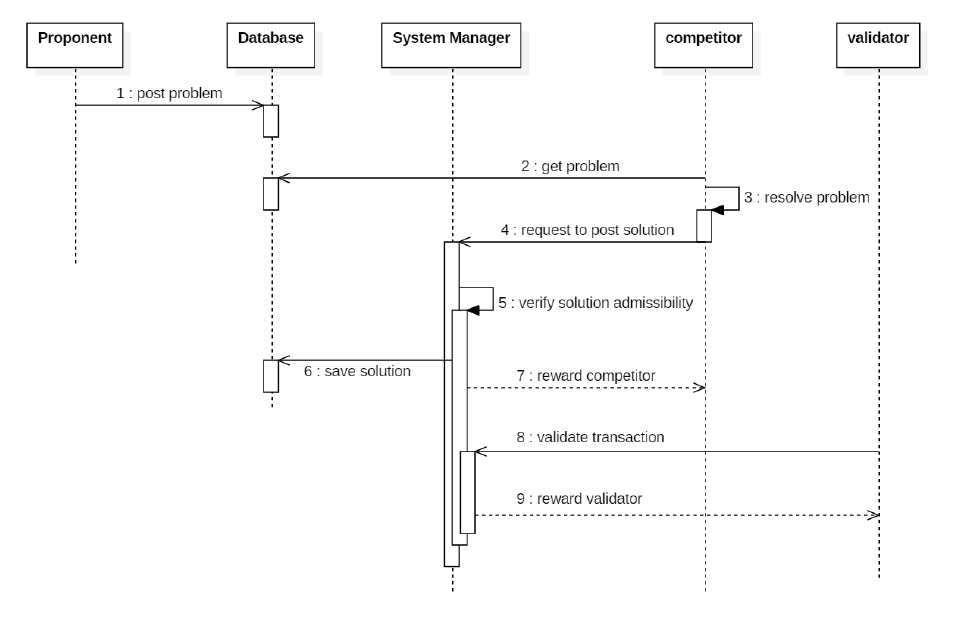
Figure 2. Gamified blockchain-based marketplaces: a workflow - notation loosely based on UML sequence diagrams.